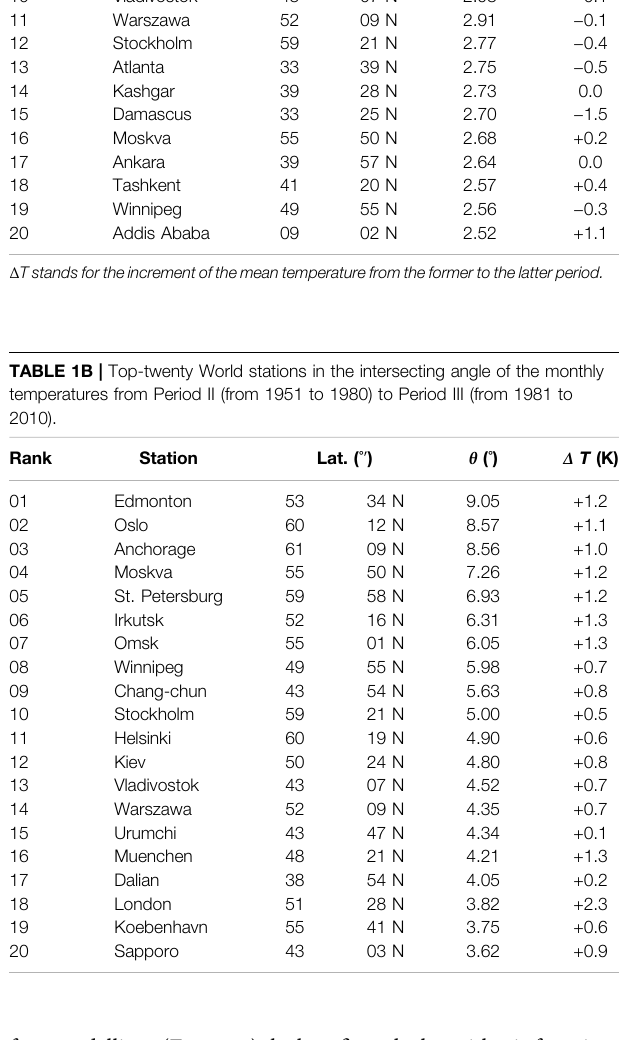
four modellings ( Eqs. 2 – 5 ) the best fi t to the logarithmic function,